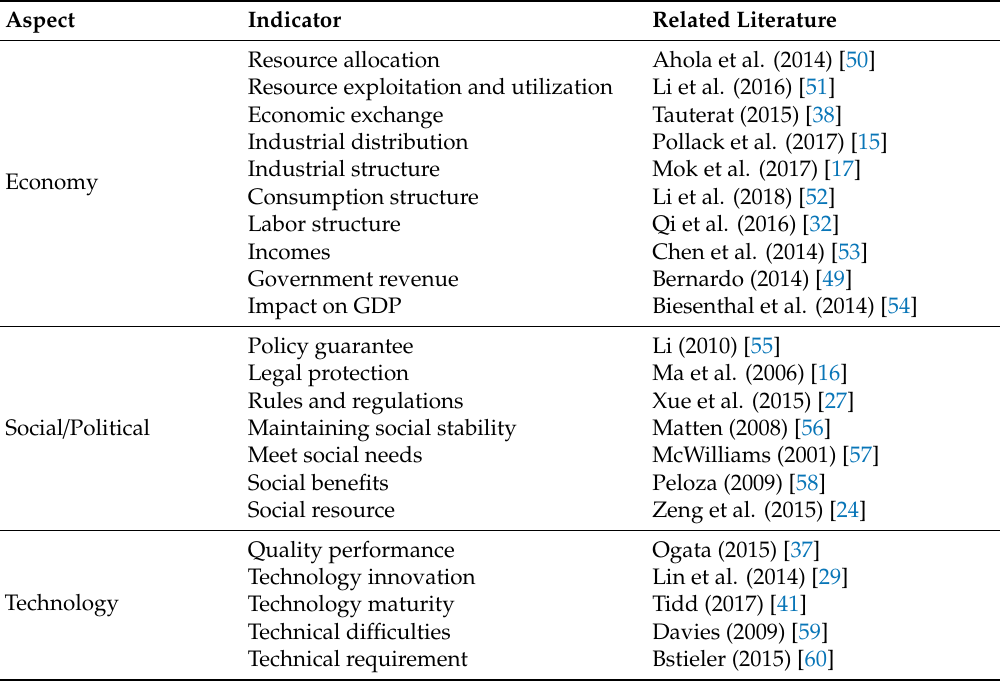
Table 1. Indicators from